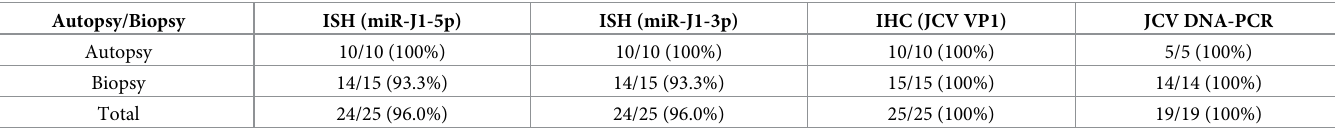
Table 2. Results of in situ hybridization (ISH), immunohistochemistry (IHC), and PCR in histological samples. Autopsy/Biopsy